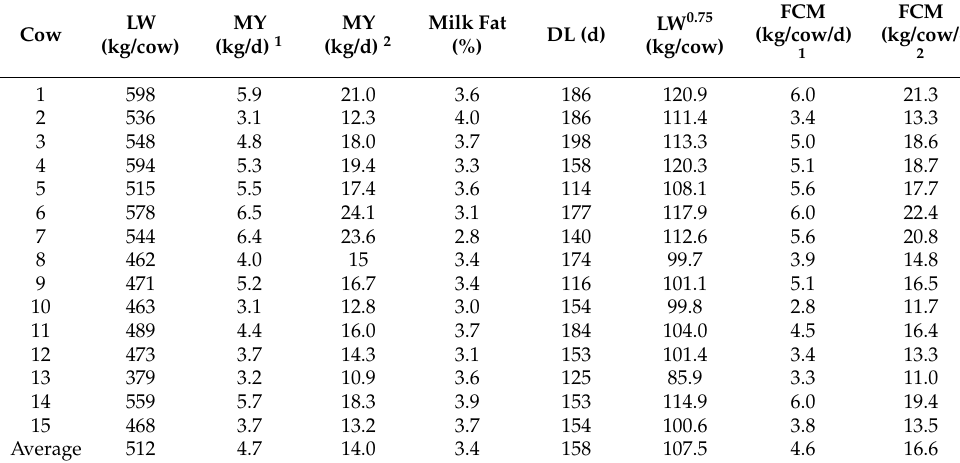
Table 2. Productive characteristics of cattle fed with two pasture managements (cut-and-carry pastures) and supplemented with different feeding